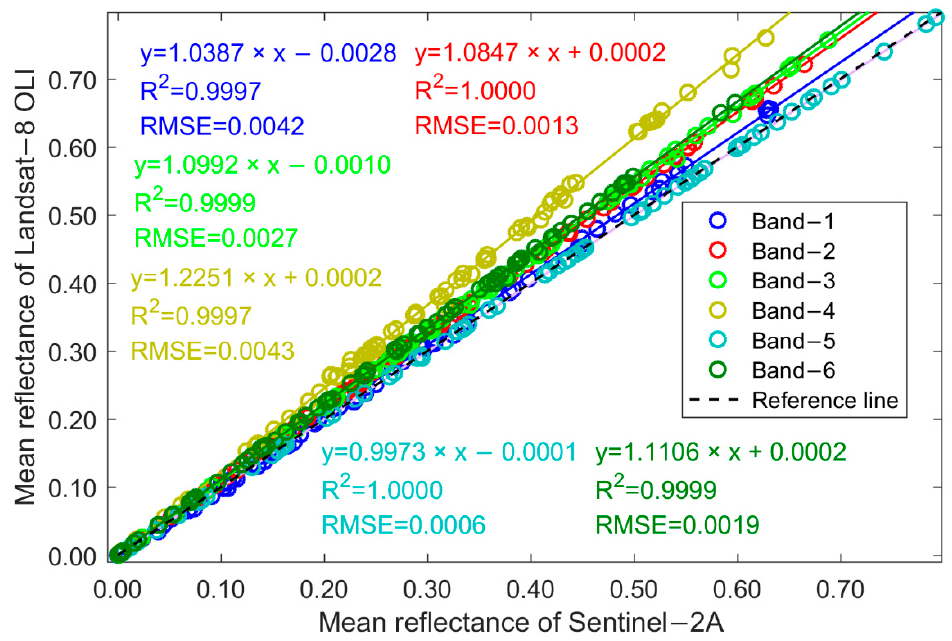
Figure 3. Normalization coefficient and errors by SpecLib − Single.